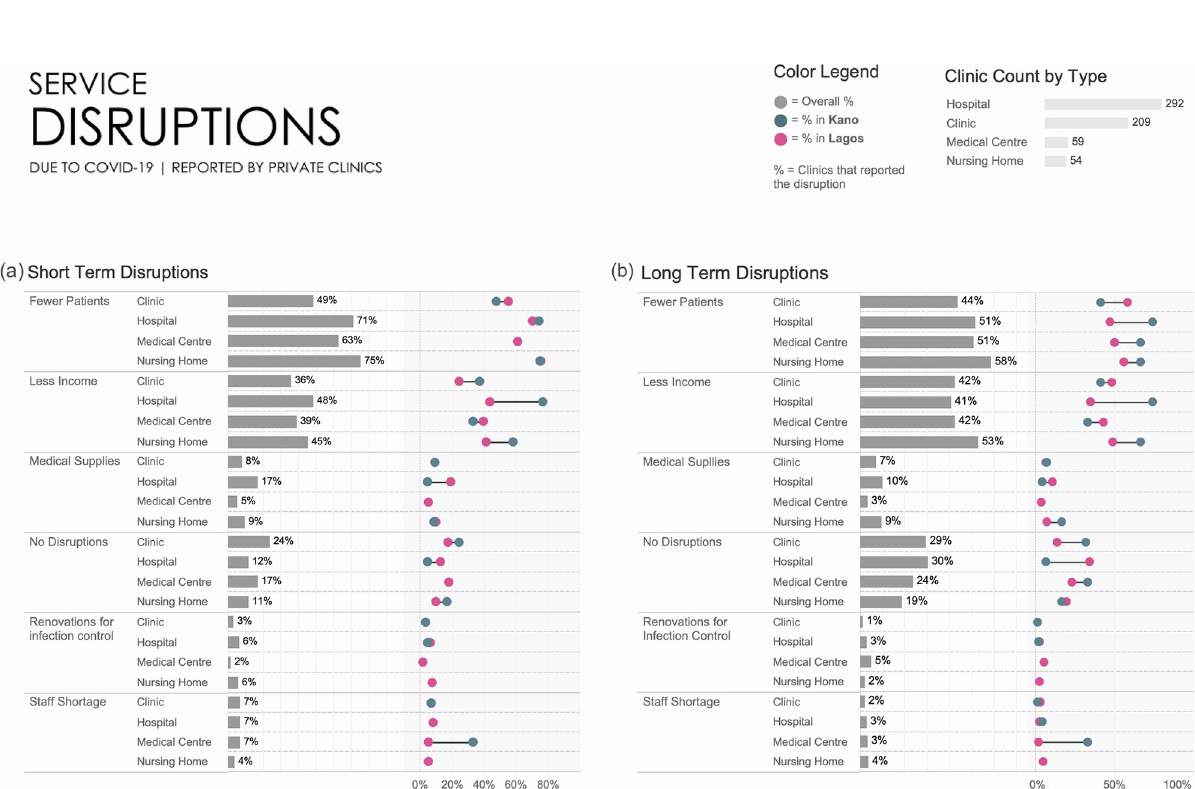
Fig 5. (a) Short- term disruptions due to COVID-19 reported by private clinics in Kano and Lagos; (b) Long-term disruptions due to COVID-19 reported by private clinics in Kano and Lagos.